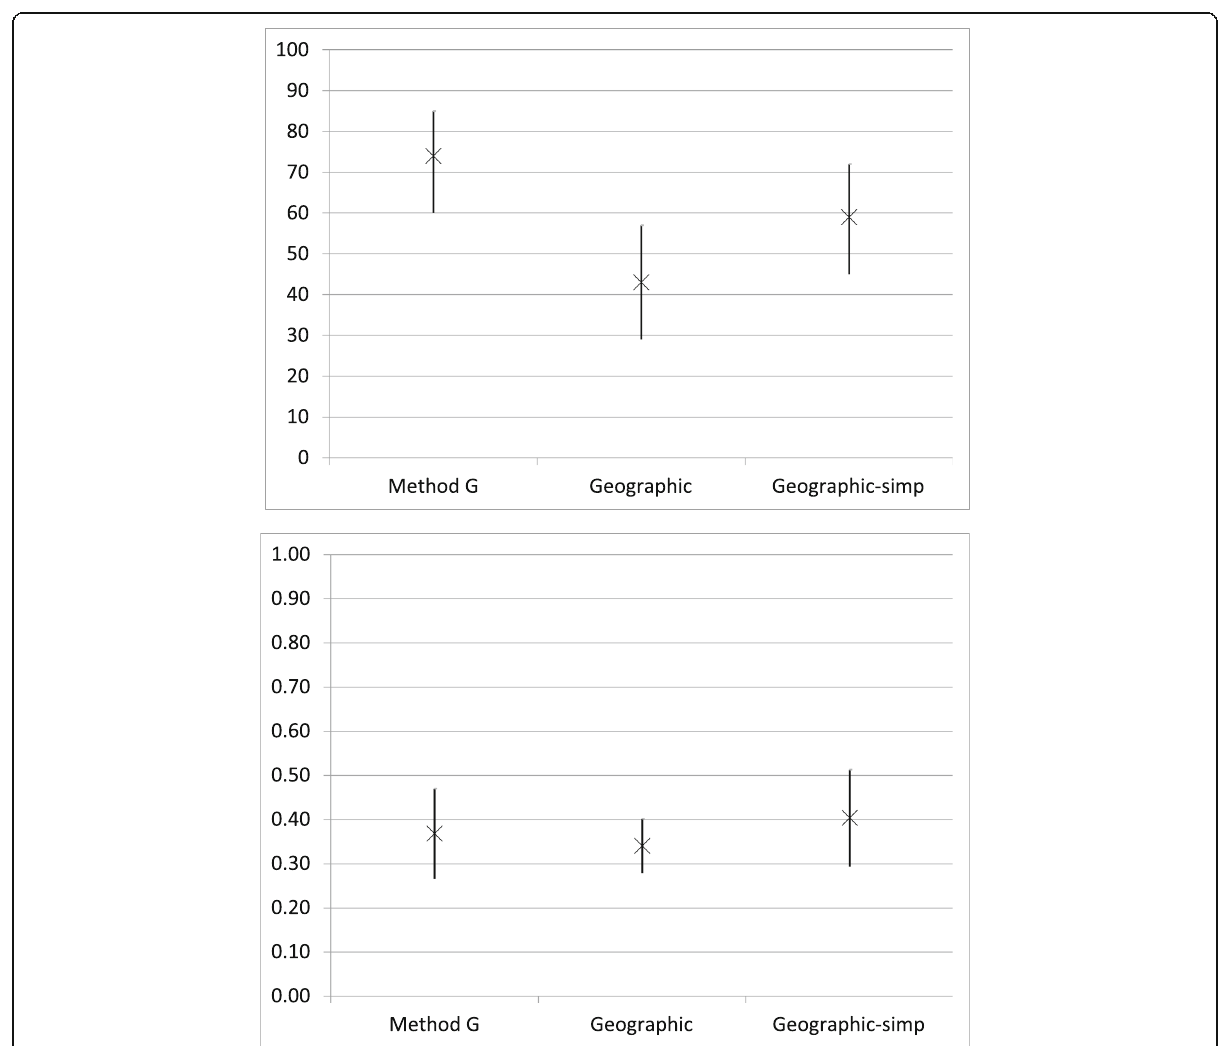
Fig. 6 Femoral Chondral Lesion Accuracy (top) and Interobserver reliability (bottom). X=accuracy (%) or kappa coefficient with 95% confidence